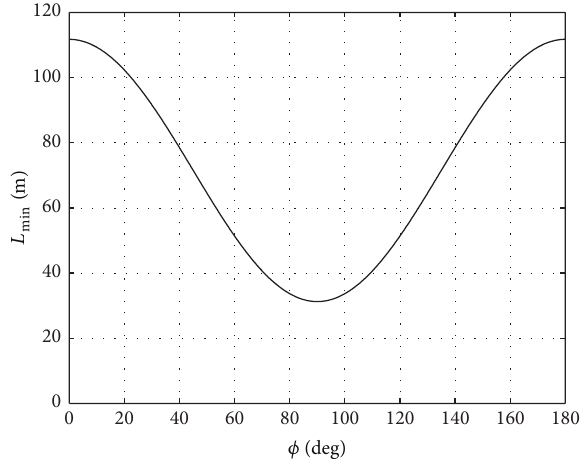
Figure 1: Simulated trend of the minimum value for detectable swell wavelength obtained from (3) by using typical values for ALOS PALSAR working in stripmap mode (6.25 m ground-range pixel = 31.25 m, 𝑉 = 7.59 km/s, 𝑅 = 663 km, and spacing); that is, 𝐿 Min | Range for 𝐻 𝑠 = 1m.